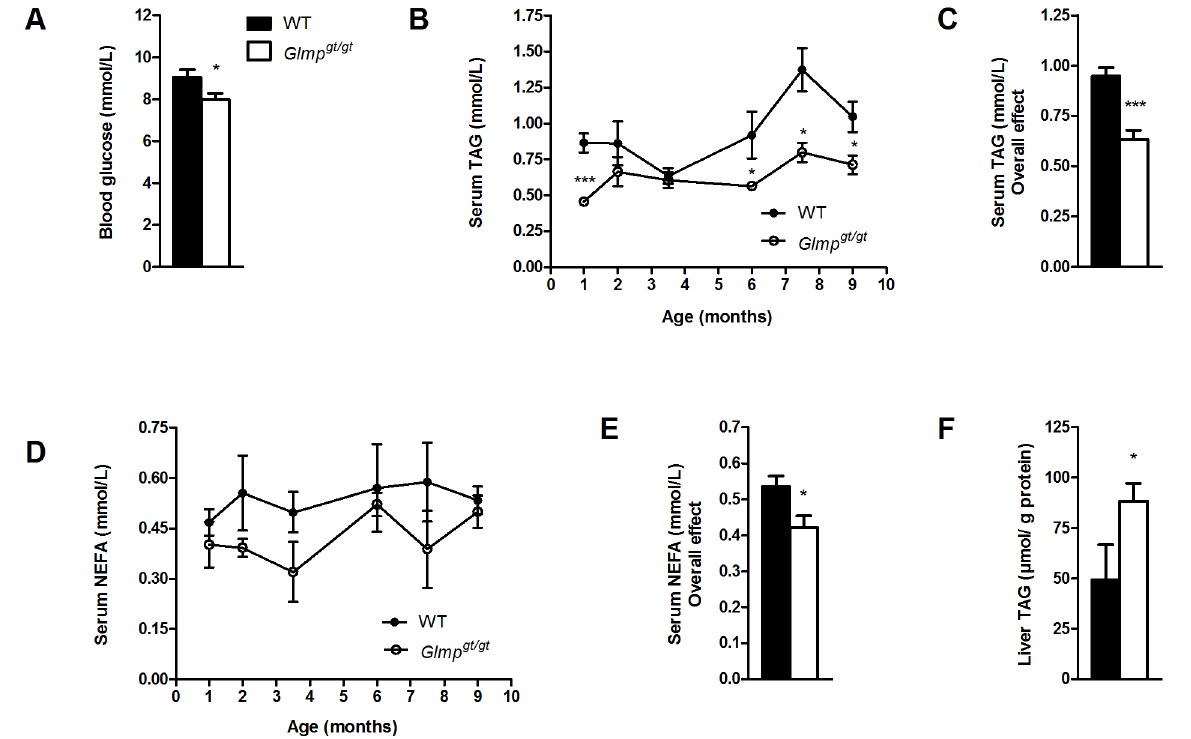
Fig 3. Glmp gt/gt mice have reduced blood glucose and circulating lipids, but increased liver triacylglycerol accumulation. (A) Blood glucose was analyzed in ad libitum fed 5 months old WT and Glmp gt/gt mice (n = 5). (B, C) The levels of circulating triacylglycerol (TAG) and (D, E) non-esterified fatty acids (NEFA) in WT and Glmp gt/gt mice were analyzed at designated time-points between 1 and 9 months of age (n = 4 – 8). (F) Liver TAG content was analyzed in 6 months old WT and Glmp gt/gt liver homogenates, and normalized to protein content (n = 6 – 7) ( * p < 0 . 05 , ** p < 0 . 01 , *** p < 0 . 005 vs. WT). Values are presented as mean ±